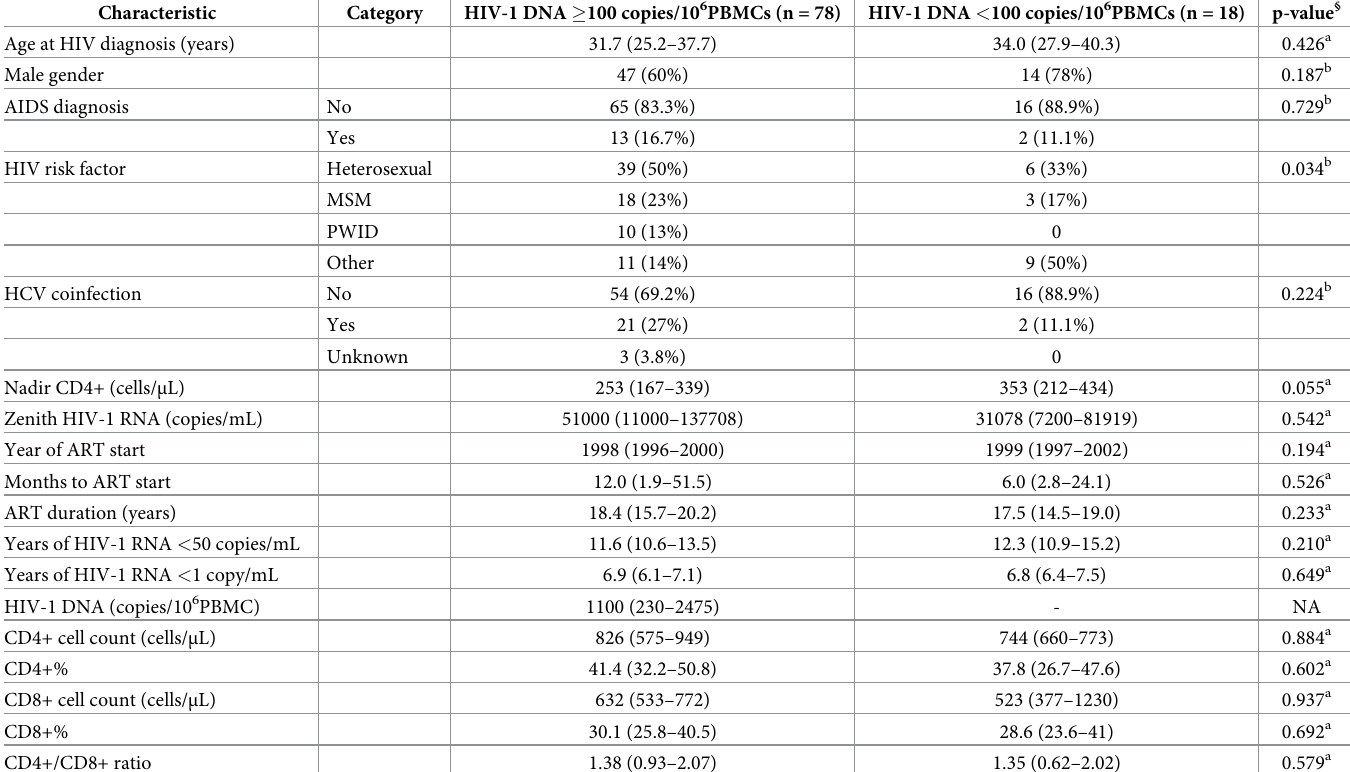
Table 1. Participants’ characteristics at HIV-1 DNA